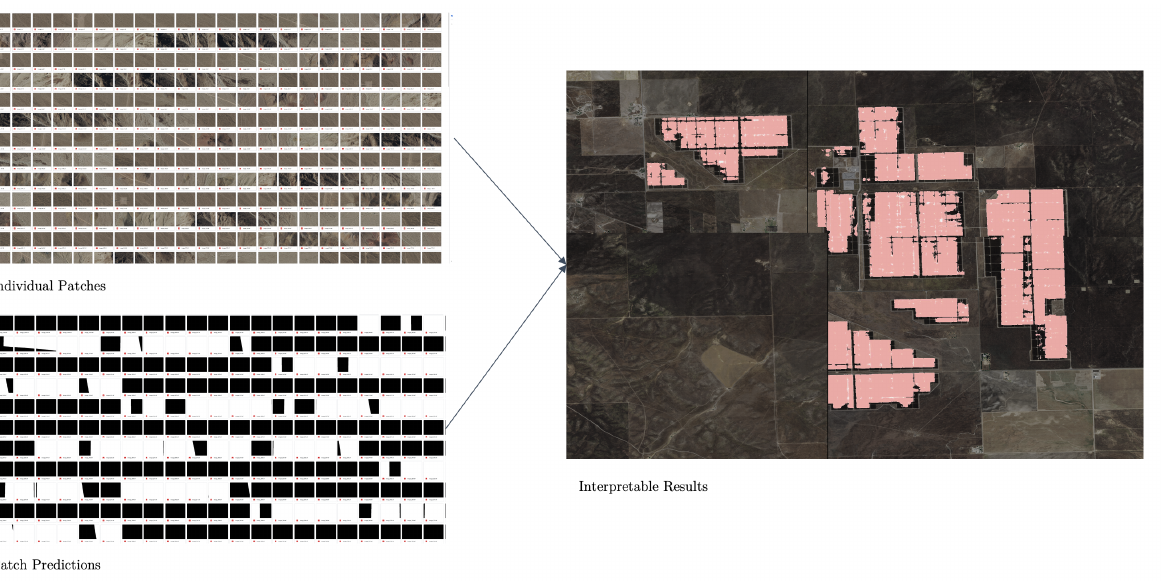
Figure 5. Postprocessing—hundreds of individual images were stitched together to visualize detected solar farm